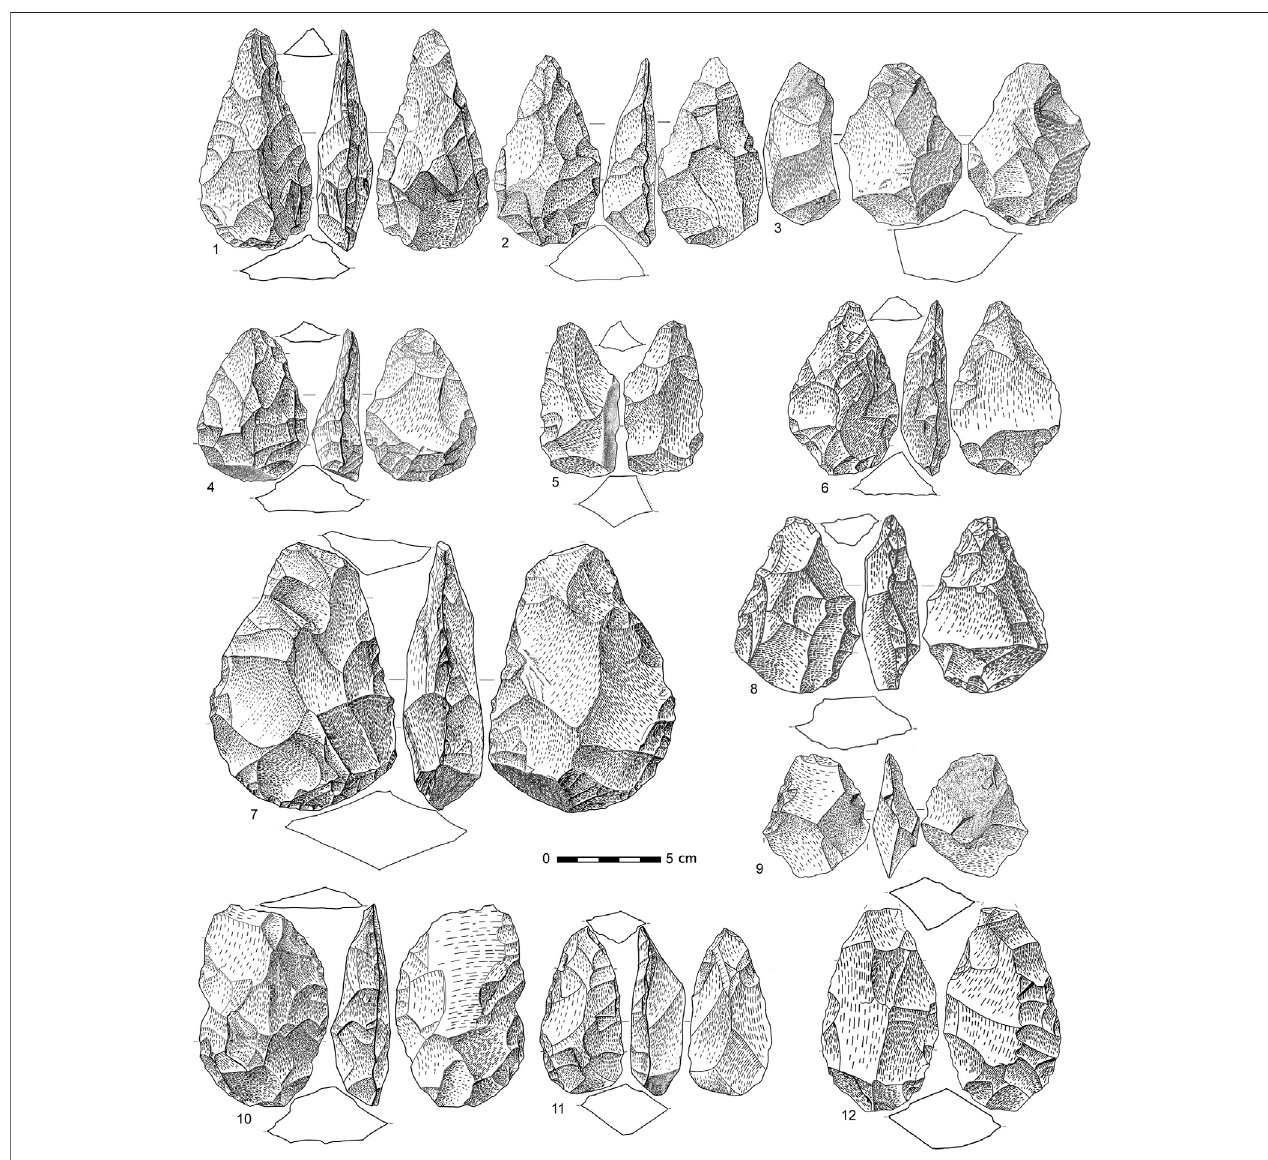
FIGURE 10 | Handaxes. Small and medium-sized lanceolate (1-2), short amygdaloid (3-4) and short amygdaloid with back (5), cordiforms (6-8), oval (10) and elongated oval (11-12). Retouched biface tip (9). All on quartzite.